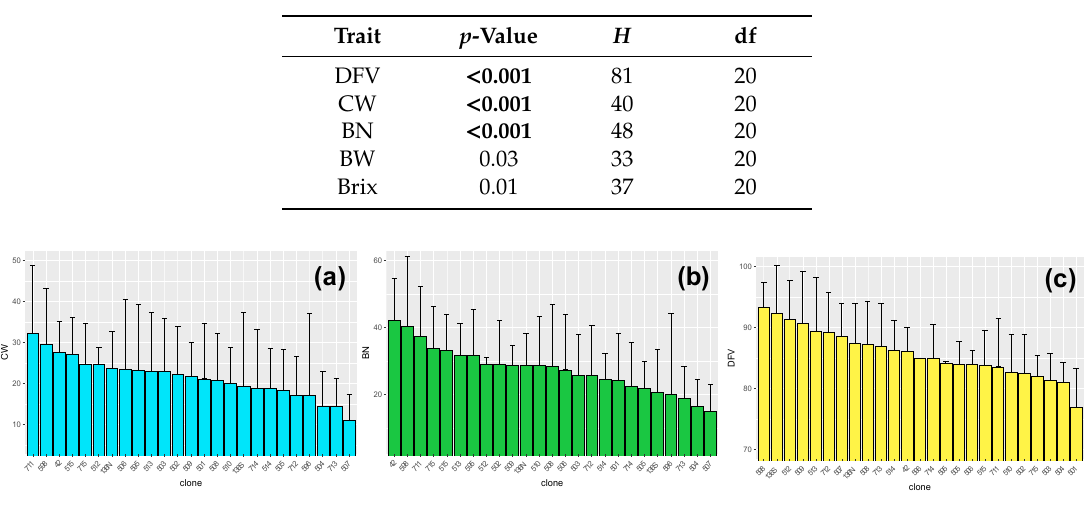
Figure 2. Mean values for phenology and agronomical traits between 21 ‘Malbec’ clones. ( a ) Cluster weight; ( b ) Berry number; ( c ) Days from flowering to veraison. Error bars represent standard error of the calculated means.